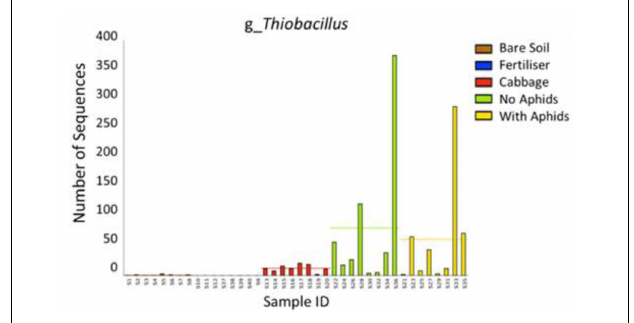
FIGURE 7 | Comparison of the abundance of Thiobacillus sequences detected in each sample. They were almost exclusively found in rhizosphere soil samples [cabbage rhizosphere at 9 weeks (red), 12 weeks without aphids (green), and 12 weeks with aphids